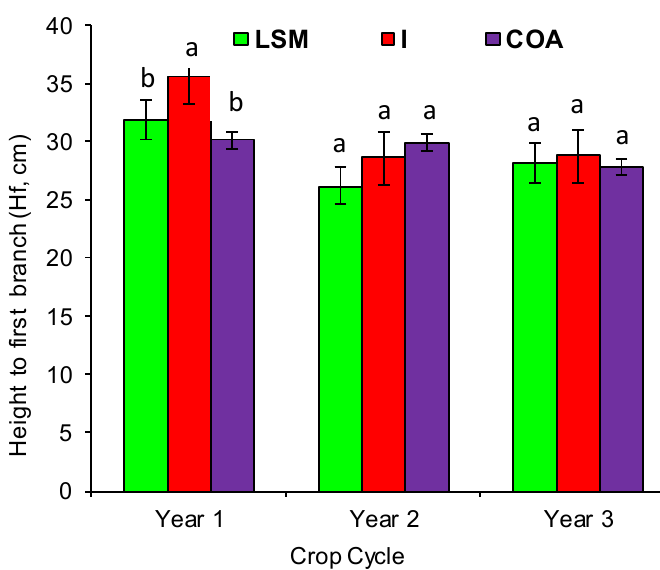
Figure 3. Height to first branch (Hf) of the celery crop, as a function of the fertilization treatment: local sheep manure (LSM), mineral (I), and commercial organic amendment (COA). “a” and “b” indicate significant differences between the three years of each treatment at the 95% confidence level.